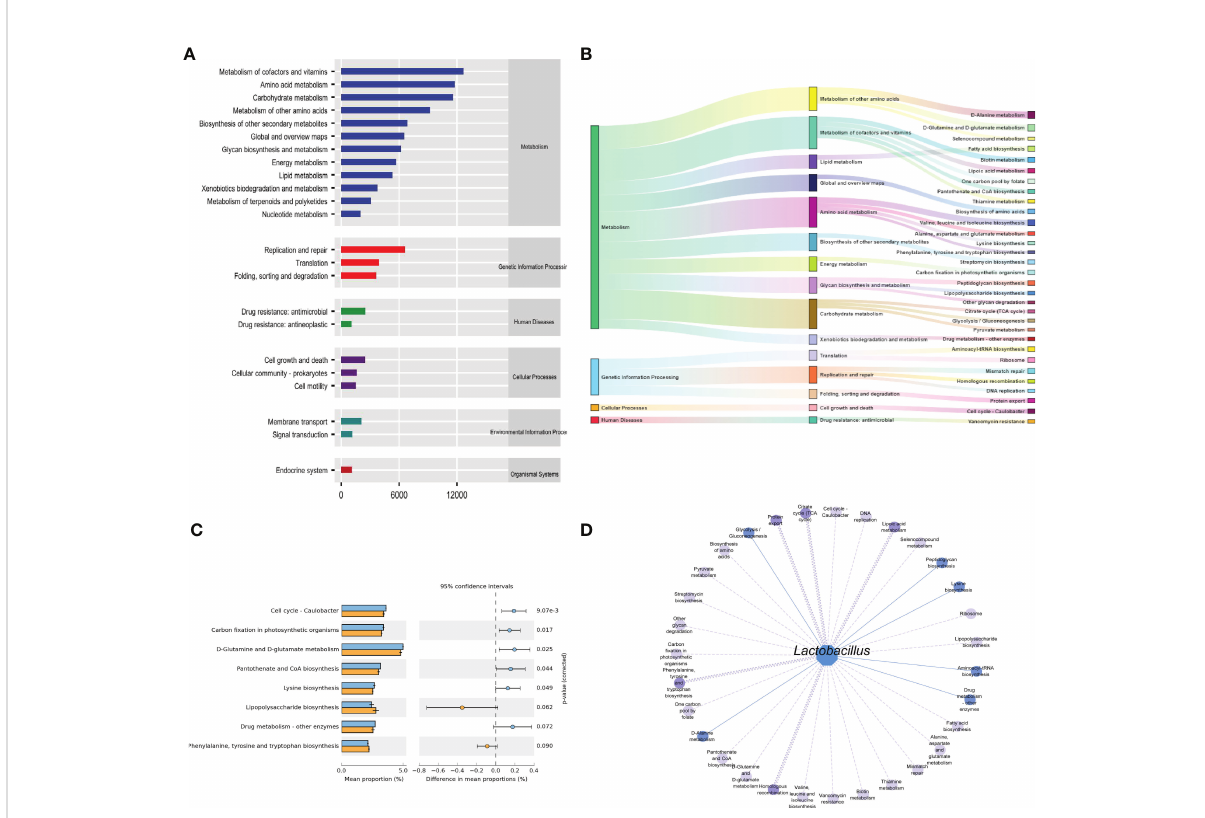
FIGURE 6 Functional analysis of intestinal mucosal microbiota. (A) Predictive abundance diagram of function. (B) Sankey diagram. (C) Predictive abundance diagram of function. (D) Interaction network of “ Lactobacillus -function. ” Solid lines indicate a positive correlation, and dotted lines are negative correlations. The line width stated the strength of the